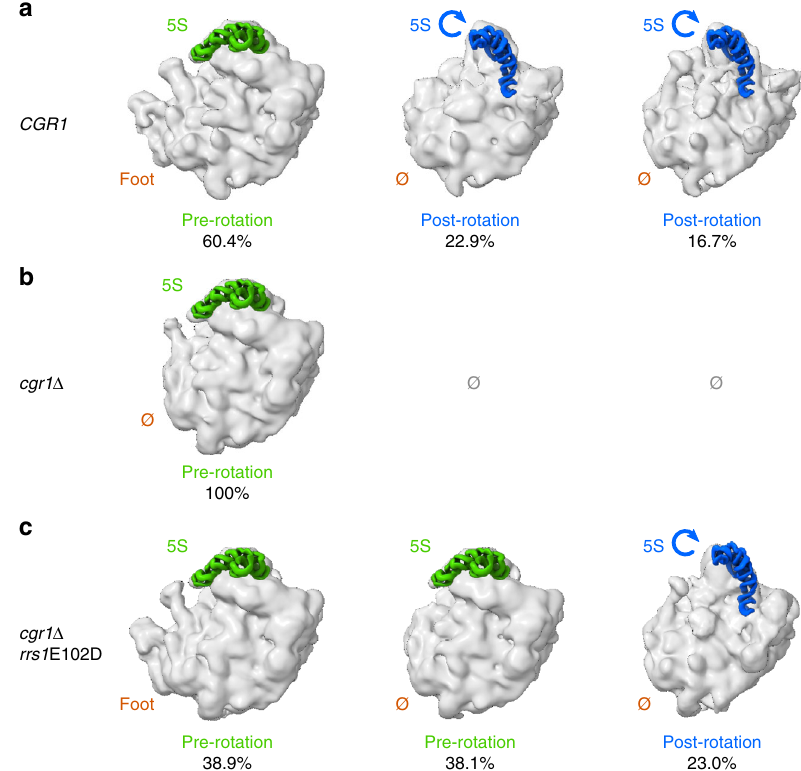
Fig. 6 Cryo-EM reveals inhibition of 5S RNP rotation in cgr1 Δ cells but restoration in rrs1E102D suppressor mutant. a – c 3D cryo-EM reconstructions of pre- 60S particles af fi nity puri fi ed via the Arx1 bait protein from the indicated yeast strains. a CGR1 control strain: rrs1 Δ [YCplac111 – RRS1 ] Arx1 – FTpA Cgr1 – HA – AID; -auxin. b cgr1 Δ depleted: rrs1 Δ [YCplac111 – RRS1 ] Arx1 – FTpA Cgr1 – HA – AID; + auxin (2 h). c cgr1 Δ depleted in the presence of the rrs1E102D suppressor: rrs1 Δ [YCplac111 – rrs1 E102D] Arx1 – FTpA Cgr1 – HA – AID + auxin (2 h). For each obtained class of the respective data set, the rotation state of the 5S is indicated by a fi t model of 5S rRNA taken from PDB: 3jct (green: pre-rotation, 20 ) or PDB: 5jcs (blue: post-rotation, 24 ). Also, the presence or absence of the ITS2-harbouring foot structure is